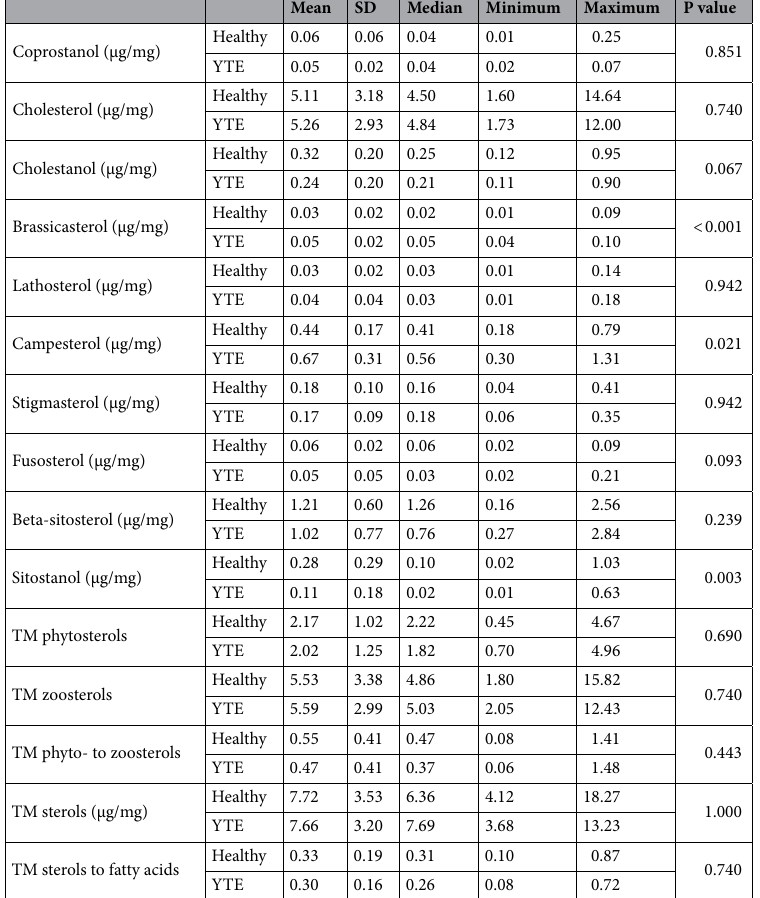
Table 3. Summary statistics of fecal sterol concentrations in healthy and YTE dogs. TM, total measured; TM Phyto- to Zoosterols; ratio of total measured phyto- to total measured zoosterols; TM Sterols to Fatty Acids; ratio of total measured sterols to total measured fatty acids; YTE, Yorkshire Terrier enteropathy; SD, standard deviation.